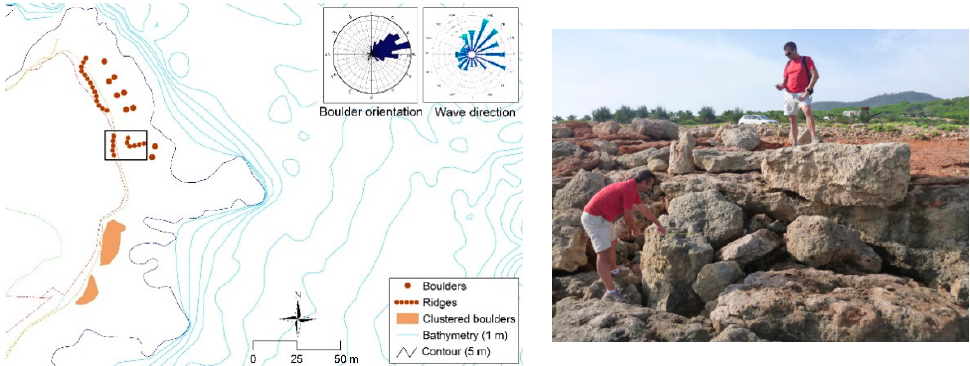
Figure 7. Geomorphological scheme of the Ses Eres Roges area. Roses show the prevailing waves ( right ) and dominant orientation of boulders ( left ).